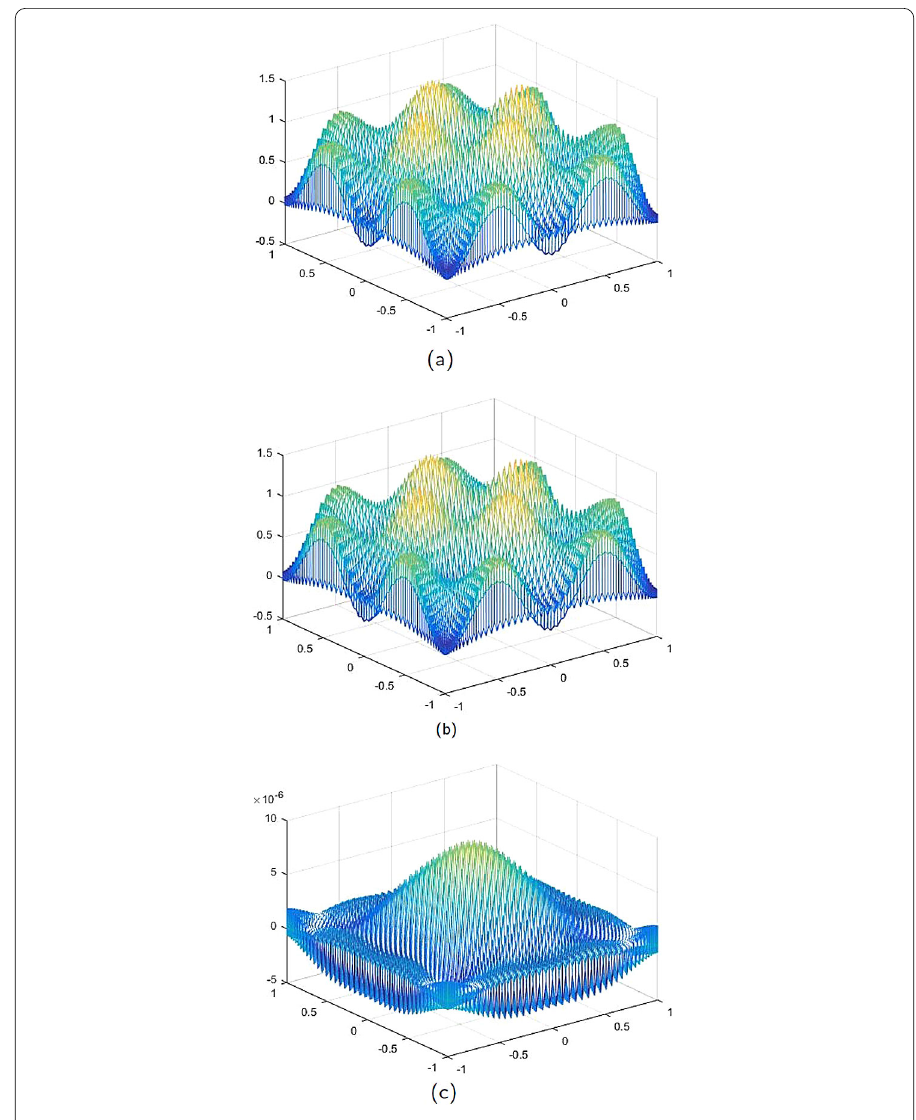
Figure 3 (a) The CNCS solution when t = 0.5. (b) The analytical solution when t = 0.5. (c) The errors between the analytical solution and CNCS solution at t =